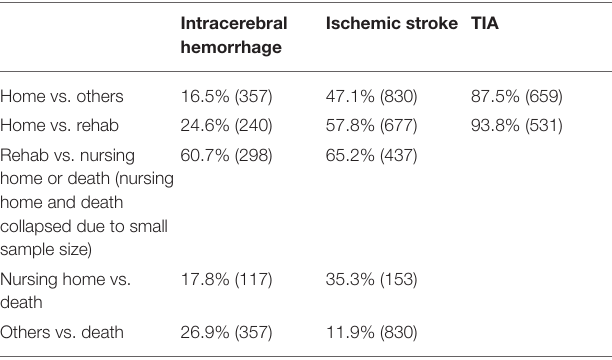
TABLE 3 | Percentage of patients that fit the model in the derivation cohort under five different prediction settings for three sub-cohorts of stroke. Intracerebral Ischemic stroke TIA hemorrhage Home vs.